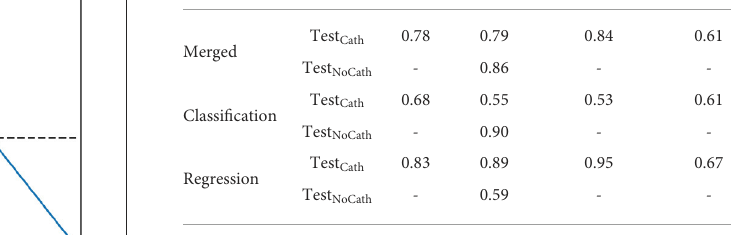
TABLE 3 Performance of our method.